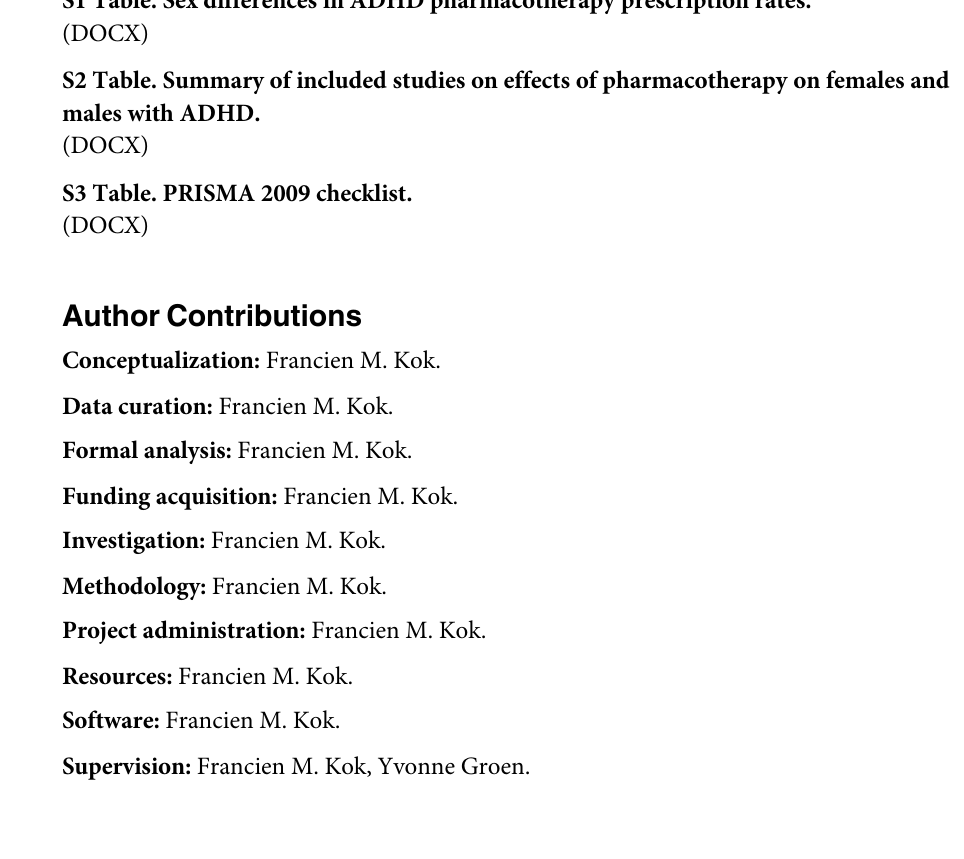
S1 Table. Sex differences in ADHD pharmacotherapy prescription rates. S2 Table. Summary of included studies on effects of pharmacotherapy on females and males with ADHD. S3 Table. PRISMA 2009